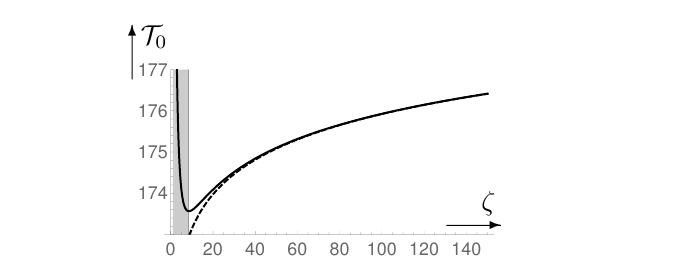
Figure 7. Age of the DM as a function of ζ . Due to inadmissible curvature values, the shaded area T 0 ζ < 8.4 must be excluded. The dashed curve represents the approximation 170.4 + 1.21 ln ζ